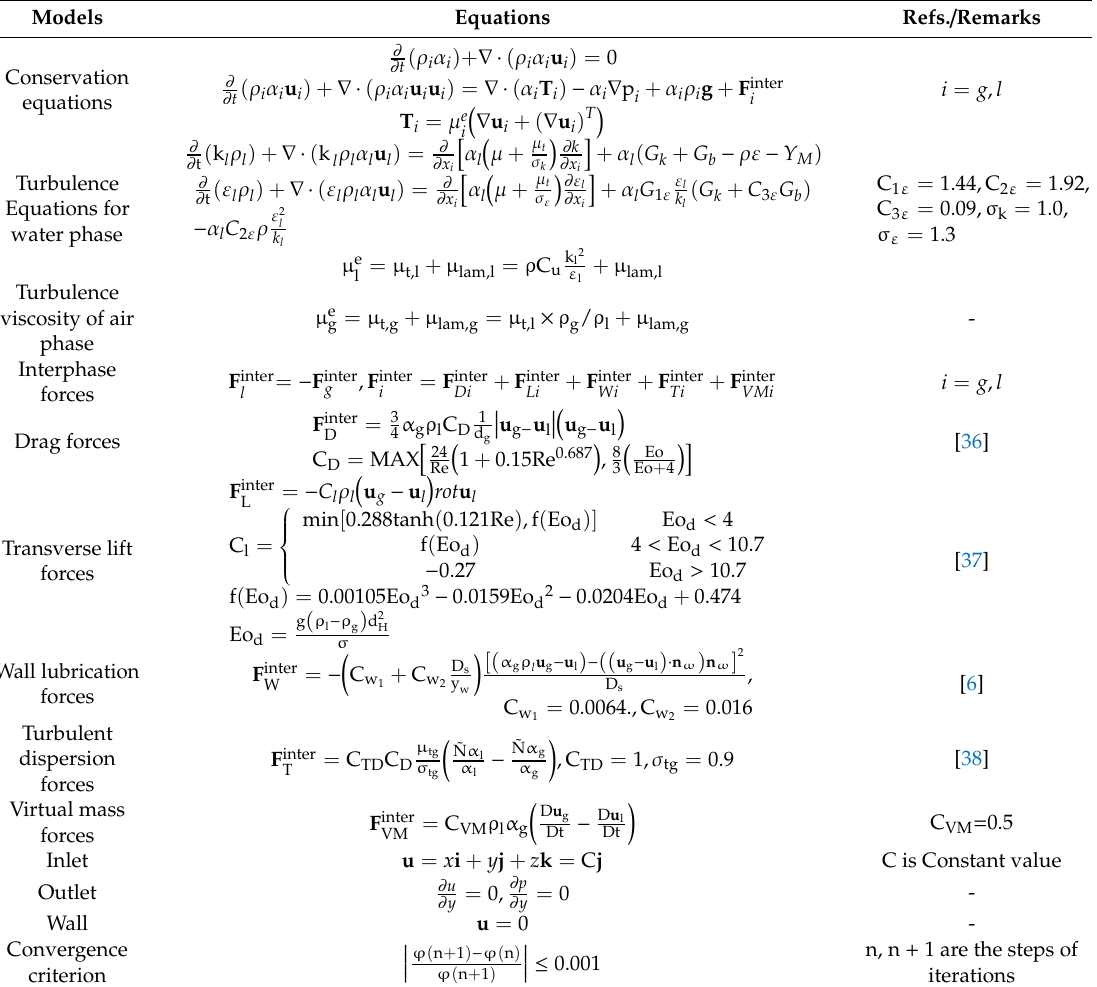
Table 2. Summary of the governing equations for two-phase flow.